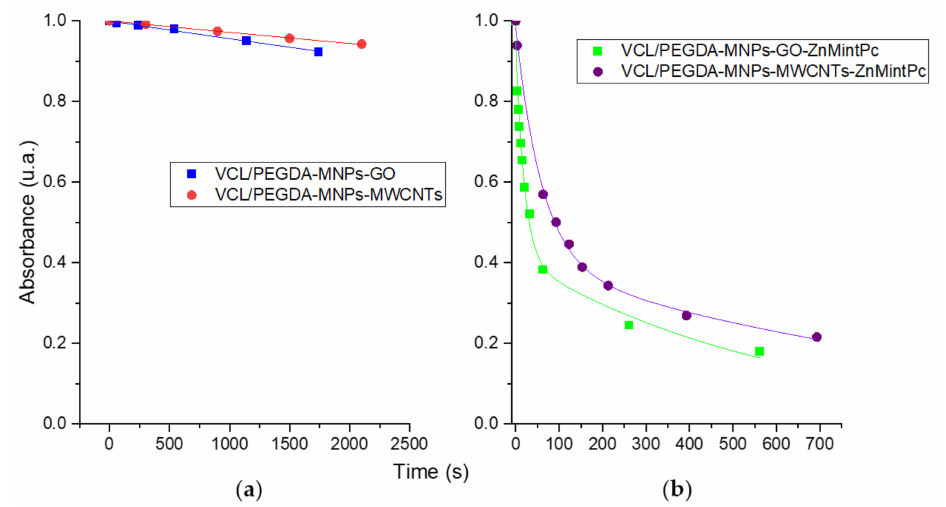
Figure 6. Decay curve of DPBF from ( a ) VCL/PEGDA-MNPs-GO and VCL/PEGDA-MNPs- MWCNTs; ( b ) VCL/PEGDA-MNPs-GO-ZnMintPc and VCL/PEGDA-MNPs-MWCNTs-ZnMintPc. DPBF = 18.5 mM, GO = 3.47 µ g · mL − 1 , MWCNTs = 3.47 µ g · mL − 1 , MNPs = 93.3 µ g · mL − 1